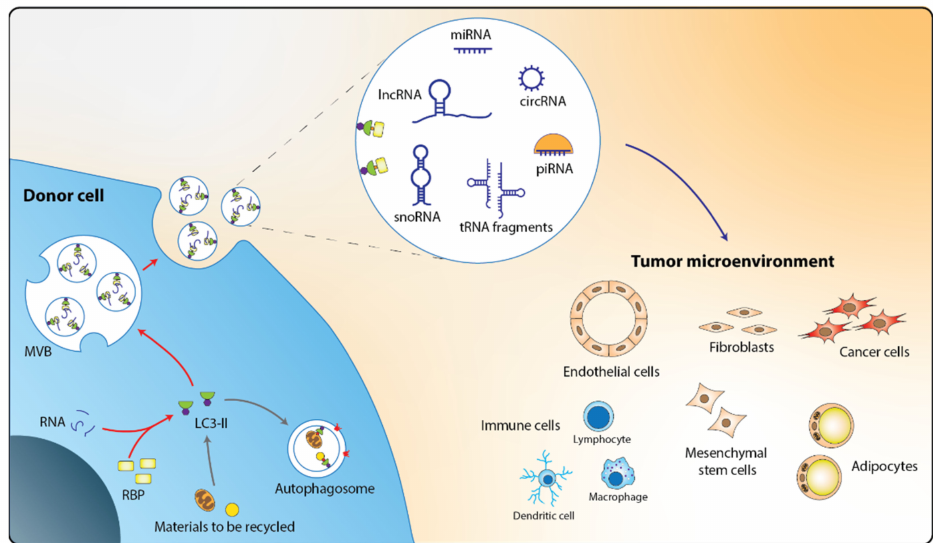
Figure 1. Autophagy mediate crosstalk in the TME via export of ncRNAs into exosomes. In the secretory autophagy LDELS pathway, LC3-II recruits various RBP-bound ncRNAs into exosomes prior to their export from the donor cells. These molecular cargo-loaded exosomes are taken up by recipient cells in the TME. LDELS: LC3-dependent EV loading and secretion; MVB: multivesicular bodies; RBP: RNA-binding